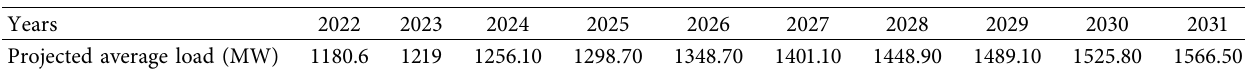
Figure 3: Load projection curve for ten year time horizon. Table 9: Test network average load projection for ten